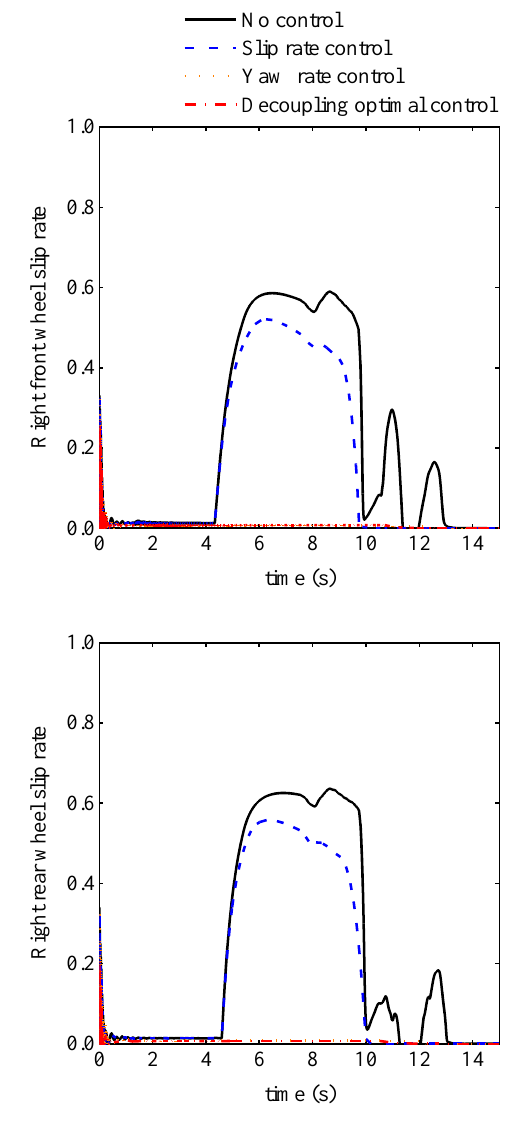
Figure 25. Slip rate.